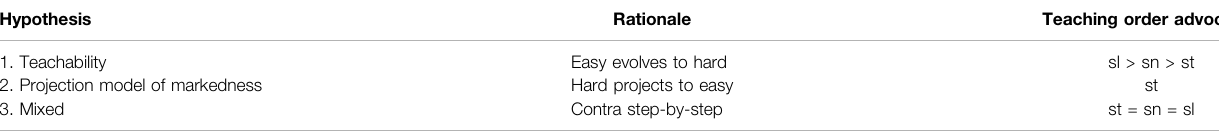
TABLE 1 | Developmental sequences and teaching: Hypotheses and advocated teaching